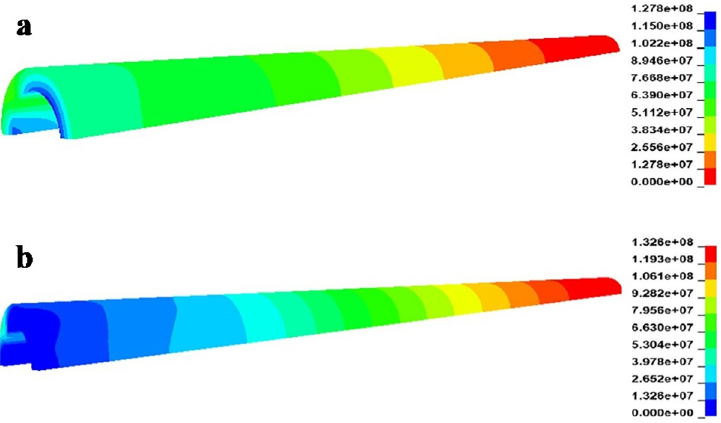
Fig 9. Stress distribution in the anchoring agent at different anchorage lengths. (a) anchorage length is 0.5 m; (b) anchorage length is 1.0 m.